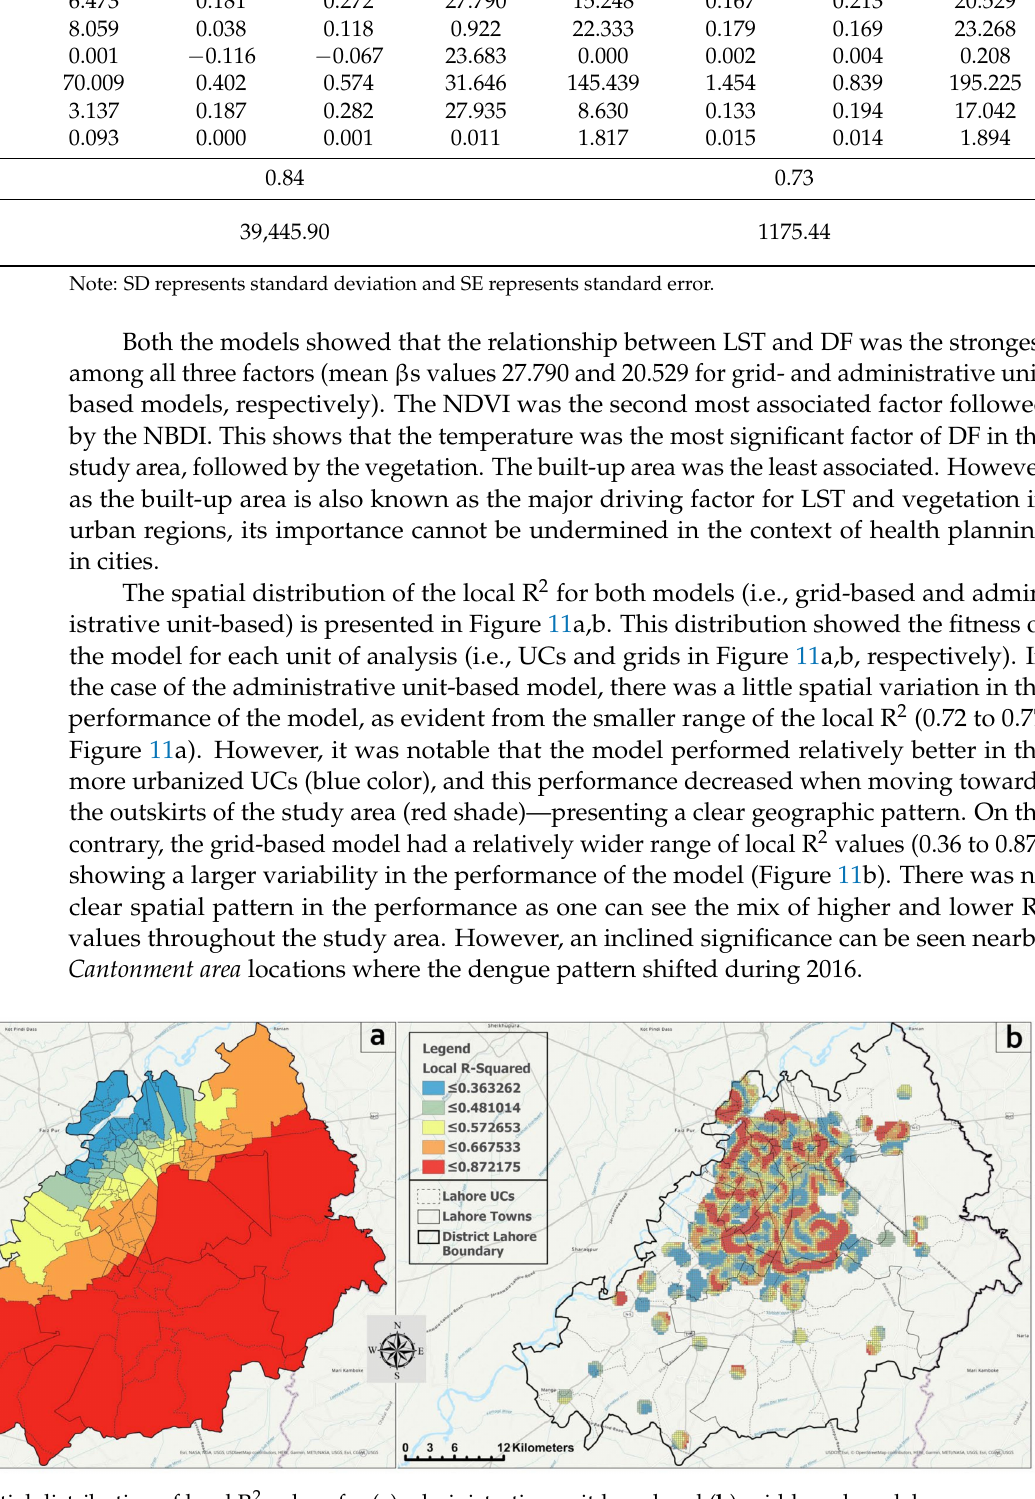
Figure 11. Spatial distribution of local R 2 values for ( a ) administrative unit-based and ( b ) grid-based